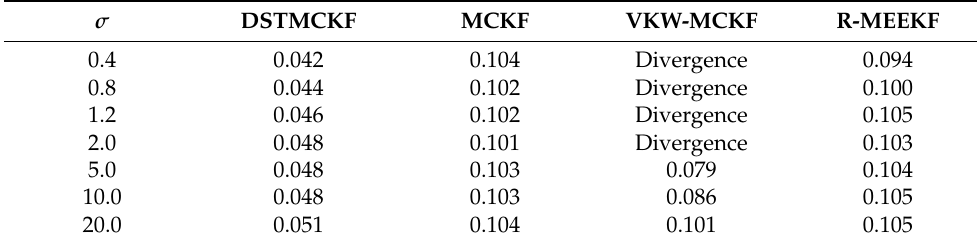
Table 5. RMSE (m) with different σ (Case